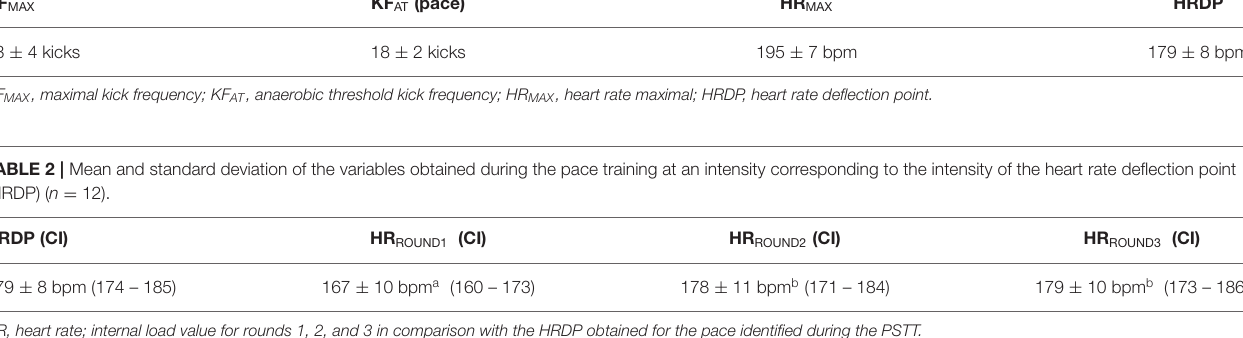
TABLE 1 | Mean and standard deviation of the variables obtained during the progressive specific taekwondo test (PSTT) ( n = 12). KF MAX KF AT (pace) HR MAX HRDP 33 ± 4 kicks